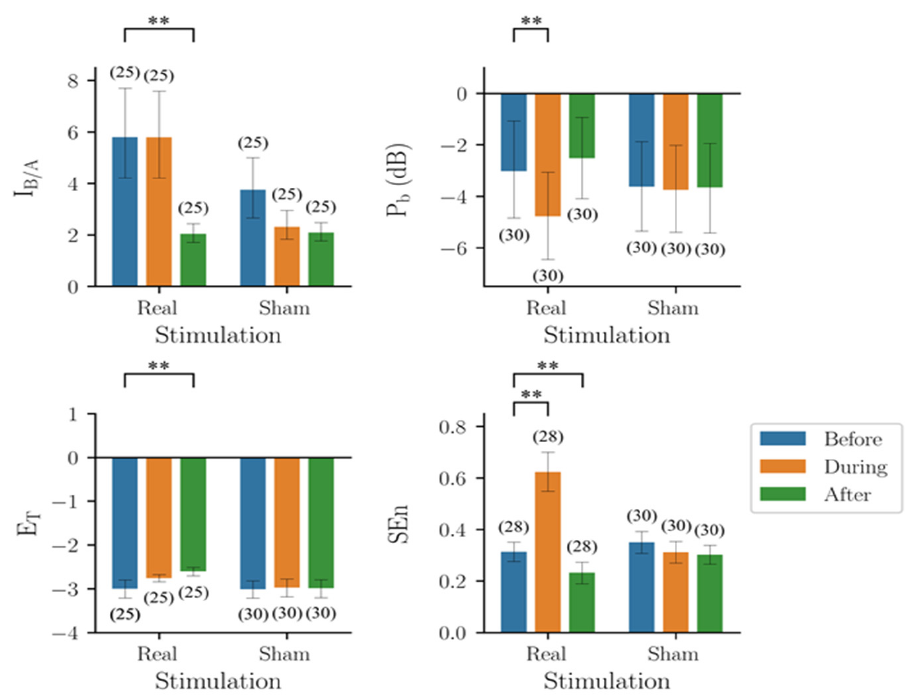
( F 2,96 = 4.34, p = 0.016).